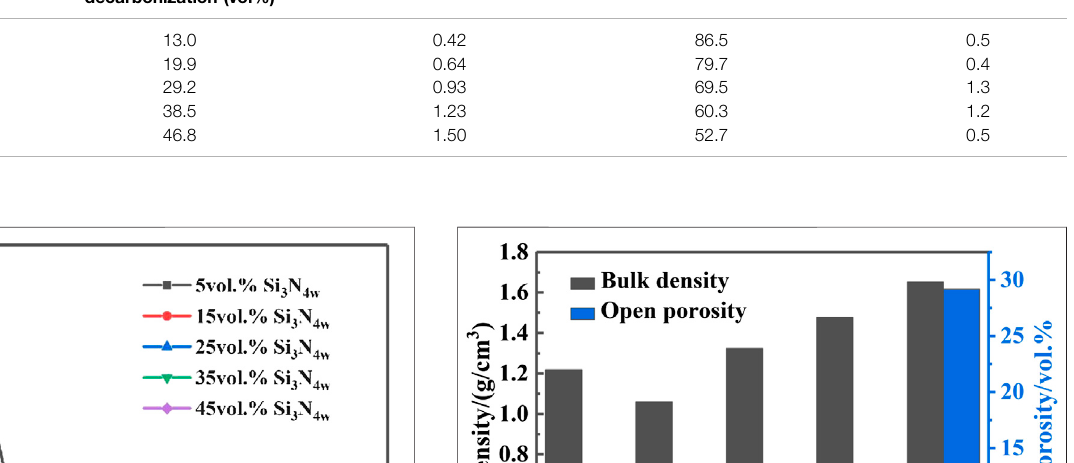
TABLE 1 | Si 3 N 4w volume fraction, bulk density, and open porosity of the fi ve kinds of Si 3 N 4w preform after decarbonization. Si 3 N 4w volume fraction in size agent